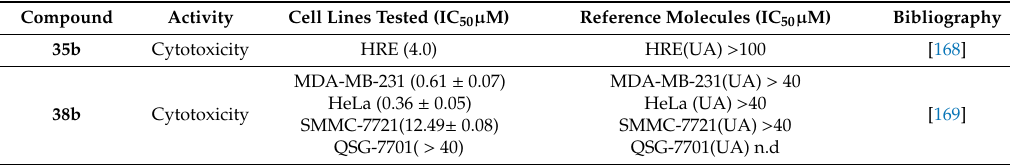
Table 6. Modification of miscellaneous groups.